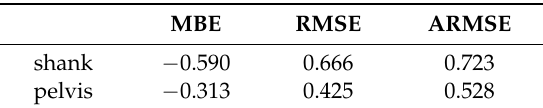
Table 8. Statistics of APV estimation in conditions of overground locomotion, in km/h (training done using the TW dataset; shank and pelvis indicate the site used as target for testing).